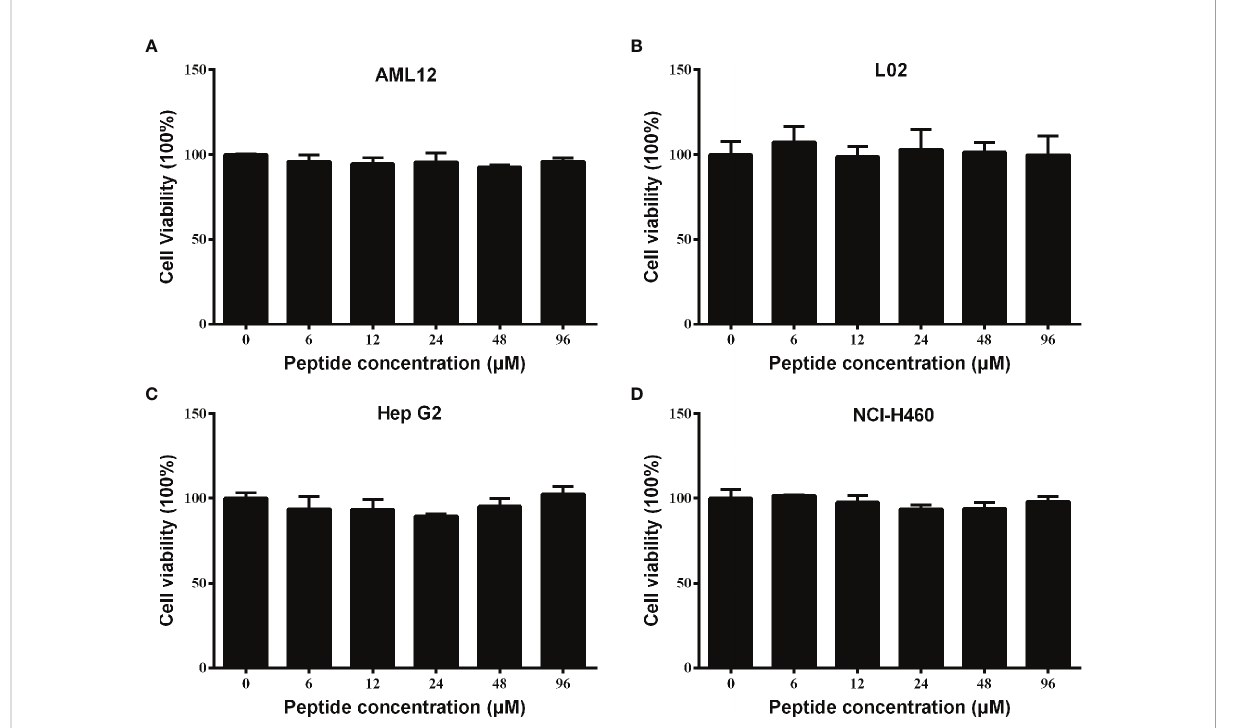
FIGURE 4 Cytotoxic effect of Spgillcin 177 – 189 towards mammalian cell lines. (A) Cytotoxicity of Spgillcin 177 – 189 on murine hepatic cell line AML 12. (B) Cytotoxicity of Spgillcin 177 – 189 on human hepatic cell line L02. (C) Anti-cancer activity of Spgillcin 177 – 189 on hepatocellular carcinoma cell line Hep G2. (D) Anti-cancer activity of Spgillcin 177 – 189 on NSCLC cell line NCI-H460. These cells were cultured in complete medium at various concentrations of Spgillcin 177 – 189 . Cell viability was measured by MTS method, and data represent the mean ± SD from three independent biological